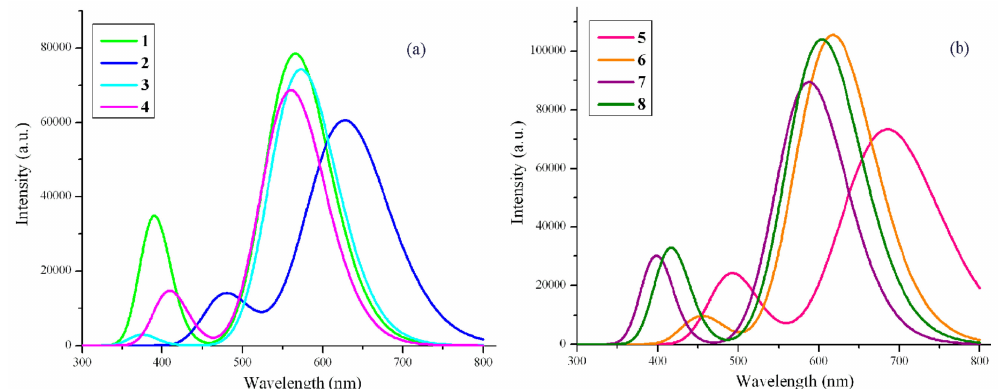
Figure 4. The calculated fluorescence spectra of the investigated molecules (value of full width at half maximum was 3000 cm − 1 ). ( a ) Molecules 1 – 4 ;( b ) Molecules 5 – 8 .